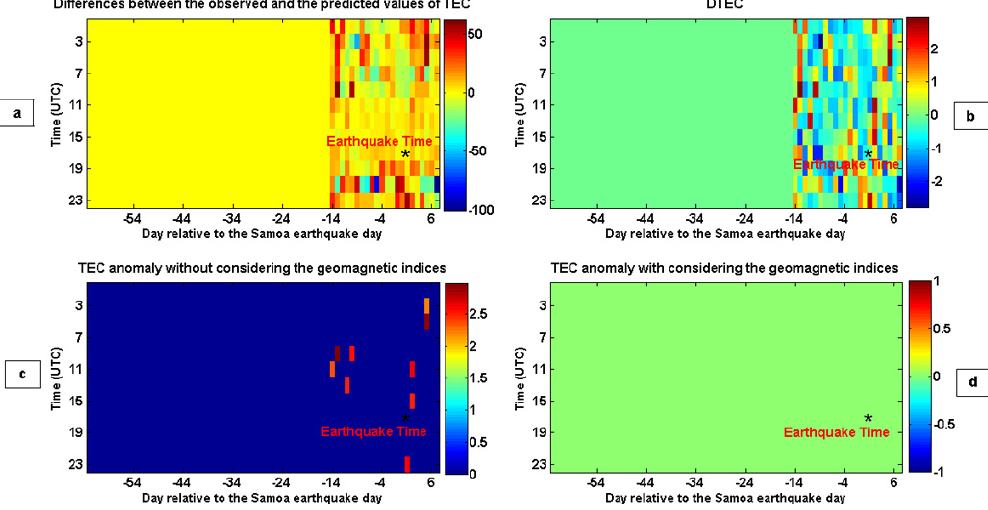
observed anomalies are most likely related to the high geo- magnetic